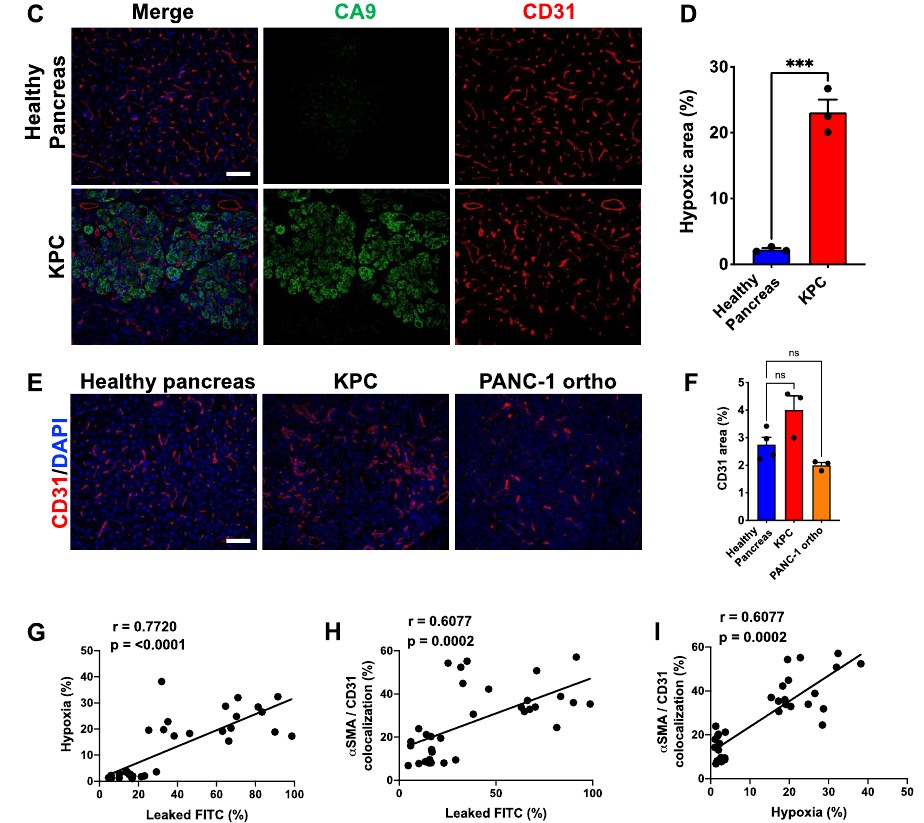
Figure 2. α SMA + pericytes’ coverage is significantly correlated with vessel leakiness and hypoxia. ( A ) Representative images of FFPE sections of KPC tumors and healthy pancreas immunolabeled for CD31. Tissue sections were also visualized using perfused 2000-kDa FITC-dextran in the indicated groups. Sections are counterstained with DAPI (blue) to visualize nuclei. ( B ) Quantification of percentage of FITC-dextran leaked to the tissue ( n = 3, all groups). ( C ) Representative images of FFPE sections of KPC tumors and healthy pancreas. Sections were immunolabeled for carbonic anhydrase 9 (CA9; hypoxia) and CD31. ( D ) Quantification of percentage of hypoxic area (CA9 + area per image) ( n = 3, all groups). ( E ) Representative images of KPC and PANC-1 tumors, and healthy pancreas tissues stained for CD31. ( F ) Quantification of MVD (WT n = 4; KPC and PANC-1 ortho-tumors n = 3). One-way ANOVA with Dunnett’s multiple comparisons was used to determine statistical significance. ( G ) Correlation of FITC-dextran leakage and hypoxic area ( n = 6). ( H ) Correlation